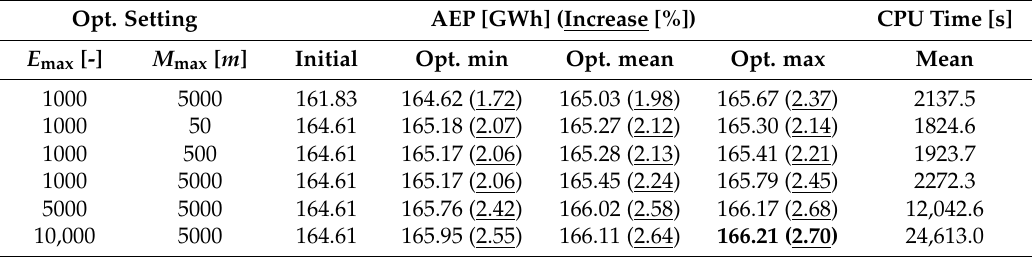
Table 2. Performance of the framework in multiple runs with different settings. Opt. Setting